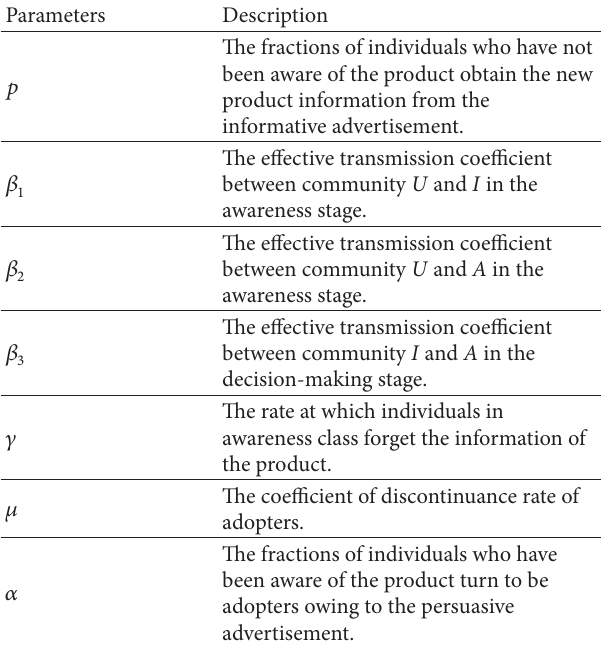
Table 1: Parameters of the